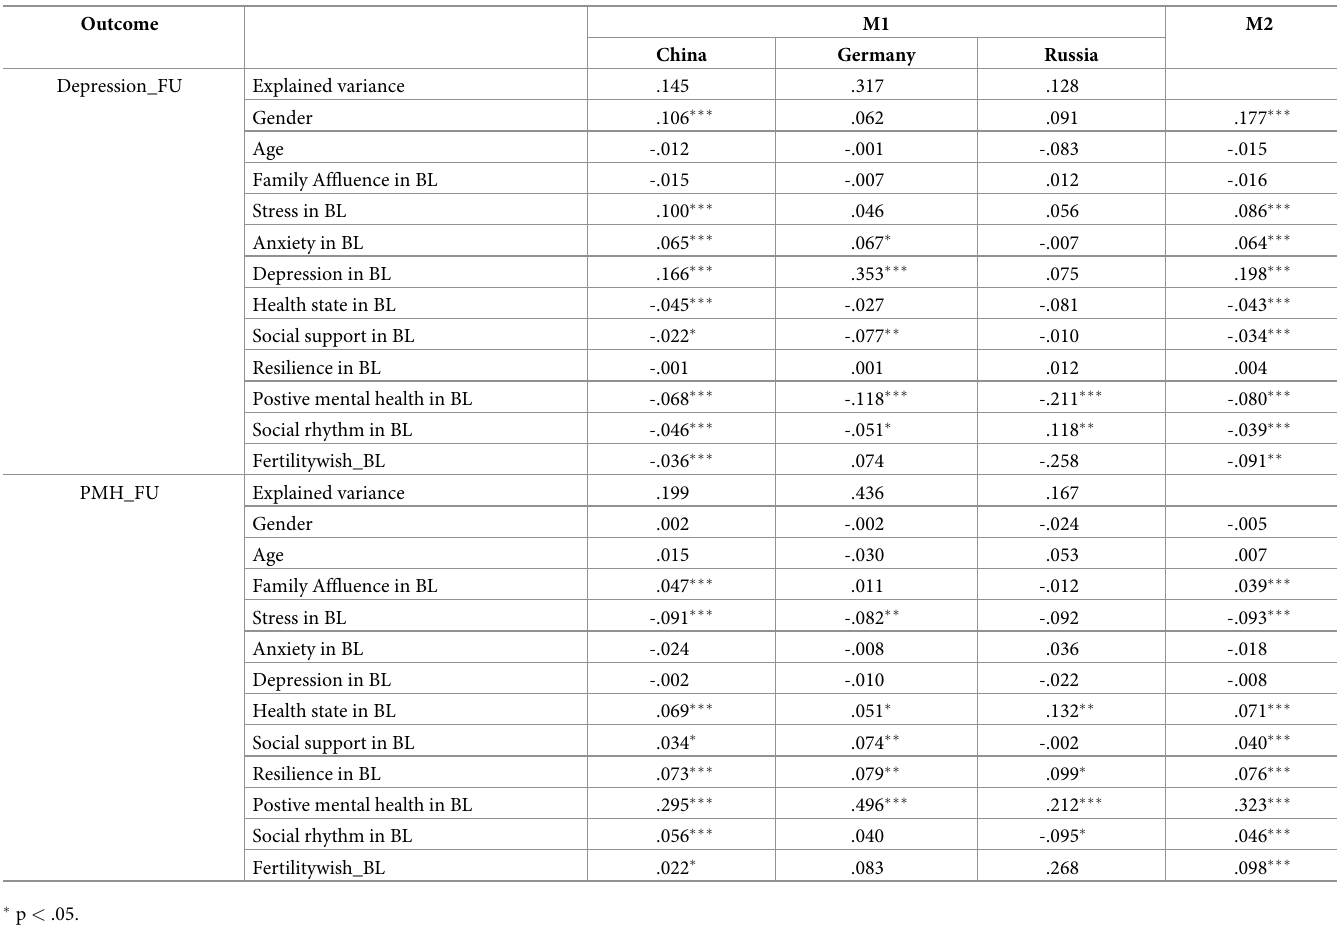
Table 4. Standardized regressions-coefficients from structural equation models.